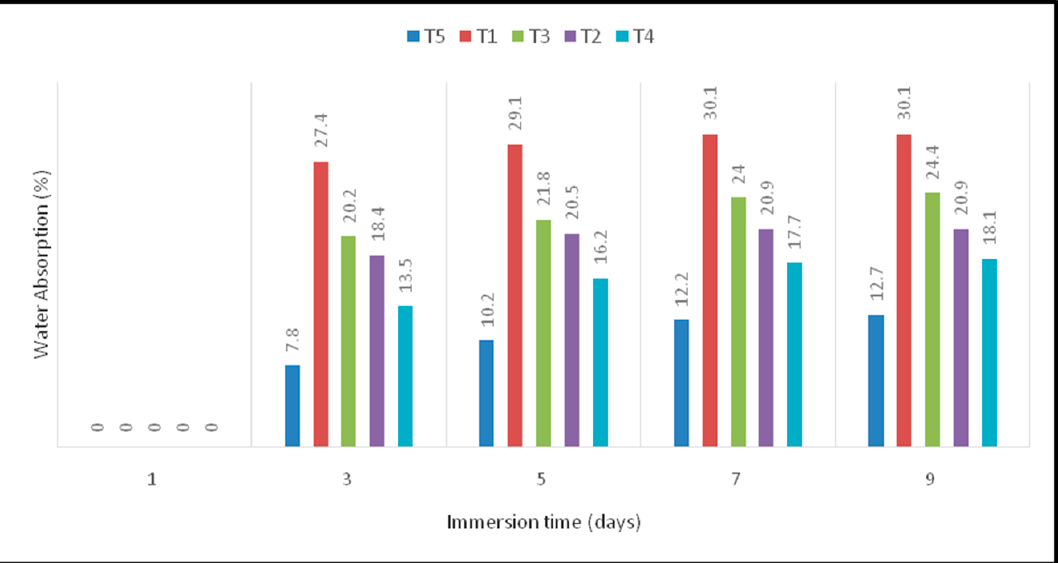
Figure 5. Water absorption (%) of oil palm EFB/kenaf woven fiber-reinforced epoxy-based bi-layer composites.